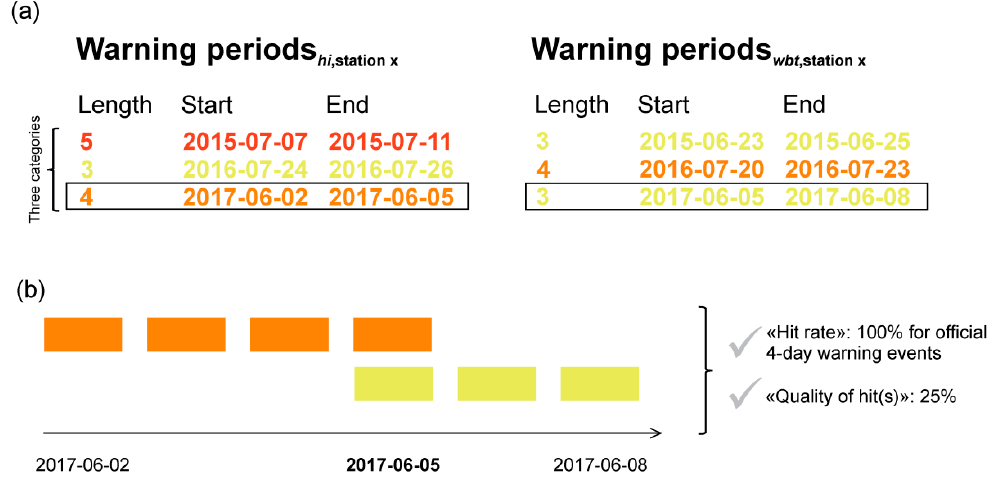
Figure 4. Exemplary warning periods for a station x, based on hi (left) and wbt (right). The warning periods are separated into three-, four- and five- (or more) day events according to their lengths. The black boxes mark warning periods that offer at least one day of overlapping warnings ( a ). In this example, the official four-day warning event is captured by one overlap (5th June 2017) when using wbt , which results in a “hit rate” of 100% in the 4-day event category and a “quality of hit(s)” of 25% ( b ).